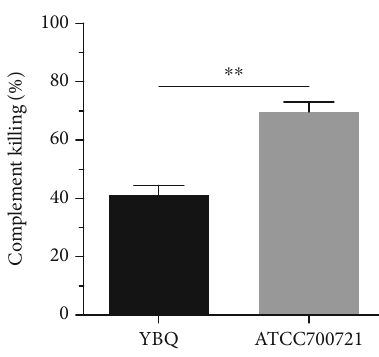
Figure 4: Susceptibility of K. pneumoniae to complement-mediated killing. 50 μ l of the bacteria suspension ( 1 × 10 4 CFUs) was mixed with 50 μ l of either active or heat-inactivated rabbit serum in 96- well microplates and incubated at 37 ° C for 1h, and viable bacteria were quanti fi ed after culture overnight. Complement mediated killing was calculated as follows: ð CFU represents heat-inactivated number, and CFU complement-active number. This experiment was performed in triplicate, and representative data from one experiment were expressed as means ± SEM . Statistical analyses were performed by Student ’ s t test. P < 0 : 01 ( ∗∗ ) compared to each